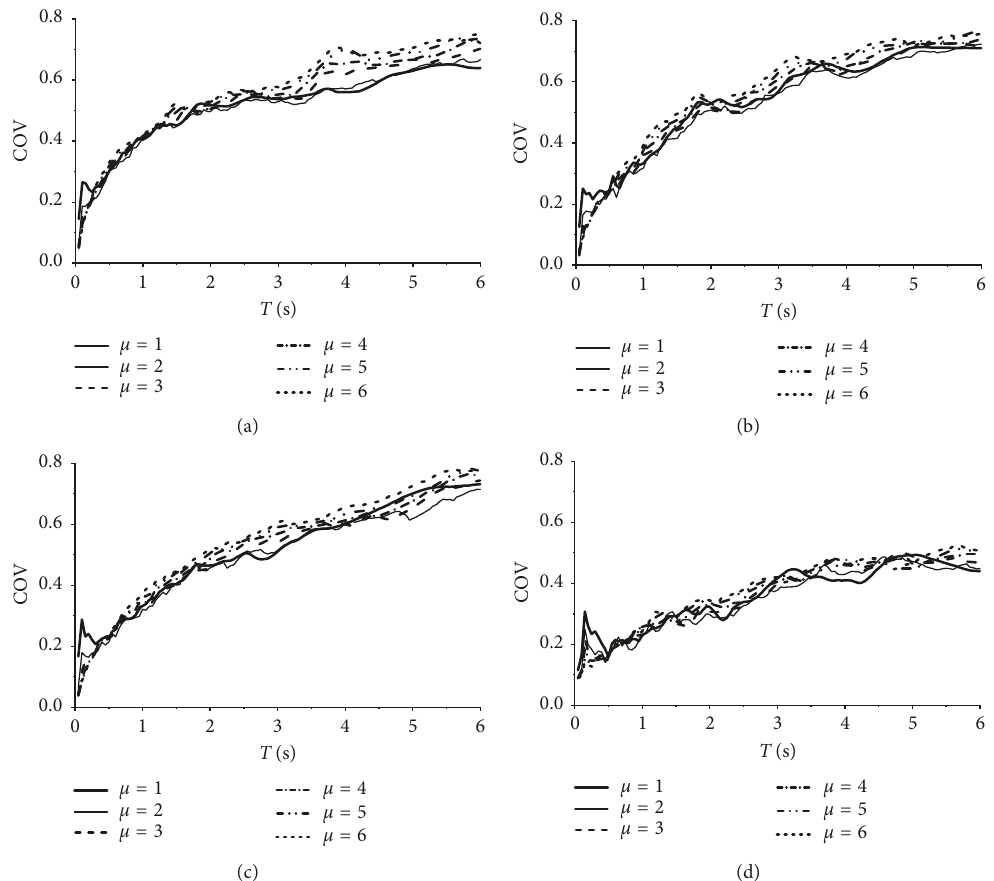
Figure 6: COV versus considering various combinations of μ and T on four different site classes: (a) site B; (b) site C; (c) site D; (d) site E.